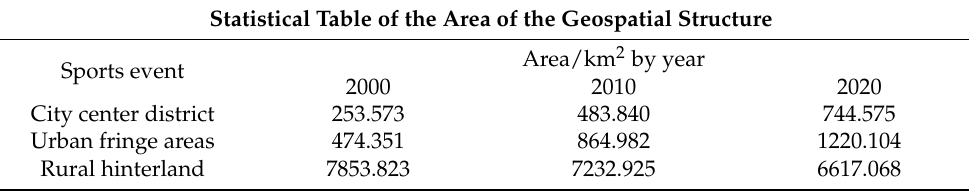
Table 3. Area statistics for the geographic spatial structure of Wuhan, 2000–2020. Statistical Table of the Area of the Geospatial Structure